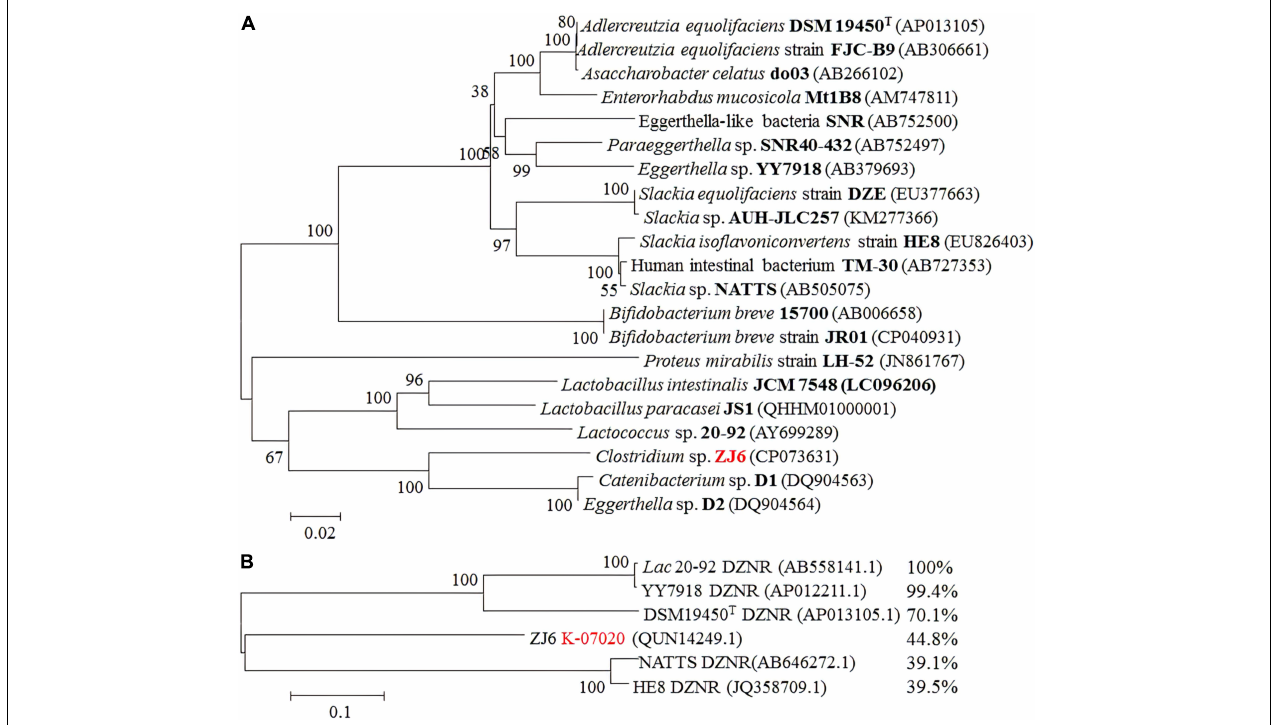
FIGURE 2 | Phylogenetic tree of Clostridium sp. ZJ6 reveals relationship with equol-producing bacteria. The accession number is shown in parenthesis. Numbers at branch points indicated bootstrap values. The scale bar corresponds to 0.01/0.02 substitutions per nucleotide position. The name of Clostridium sp. ZJ6 in Genebank is Clostridium sp. C1. (A) Phylogenetic tree analysis of 16S rRNA gene for the main equol-producing bacteria. (B) Sequence identity analysis between K-07020 and reported DZNRs, where K-07020 had 44.8% sequence identity with Lac 20_92 DZNR.